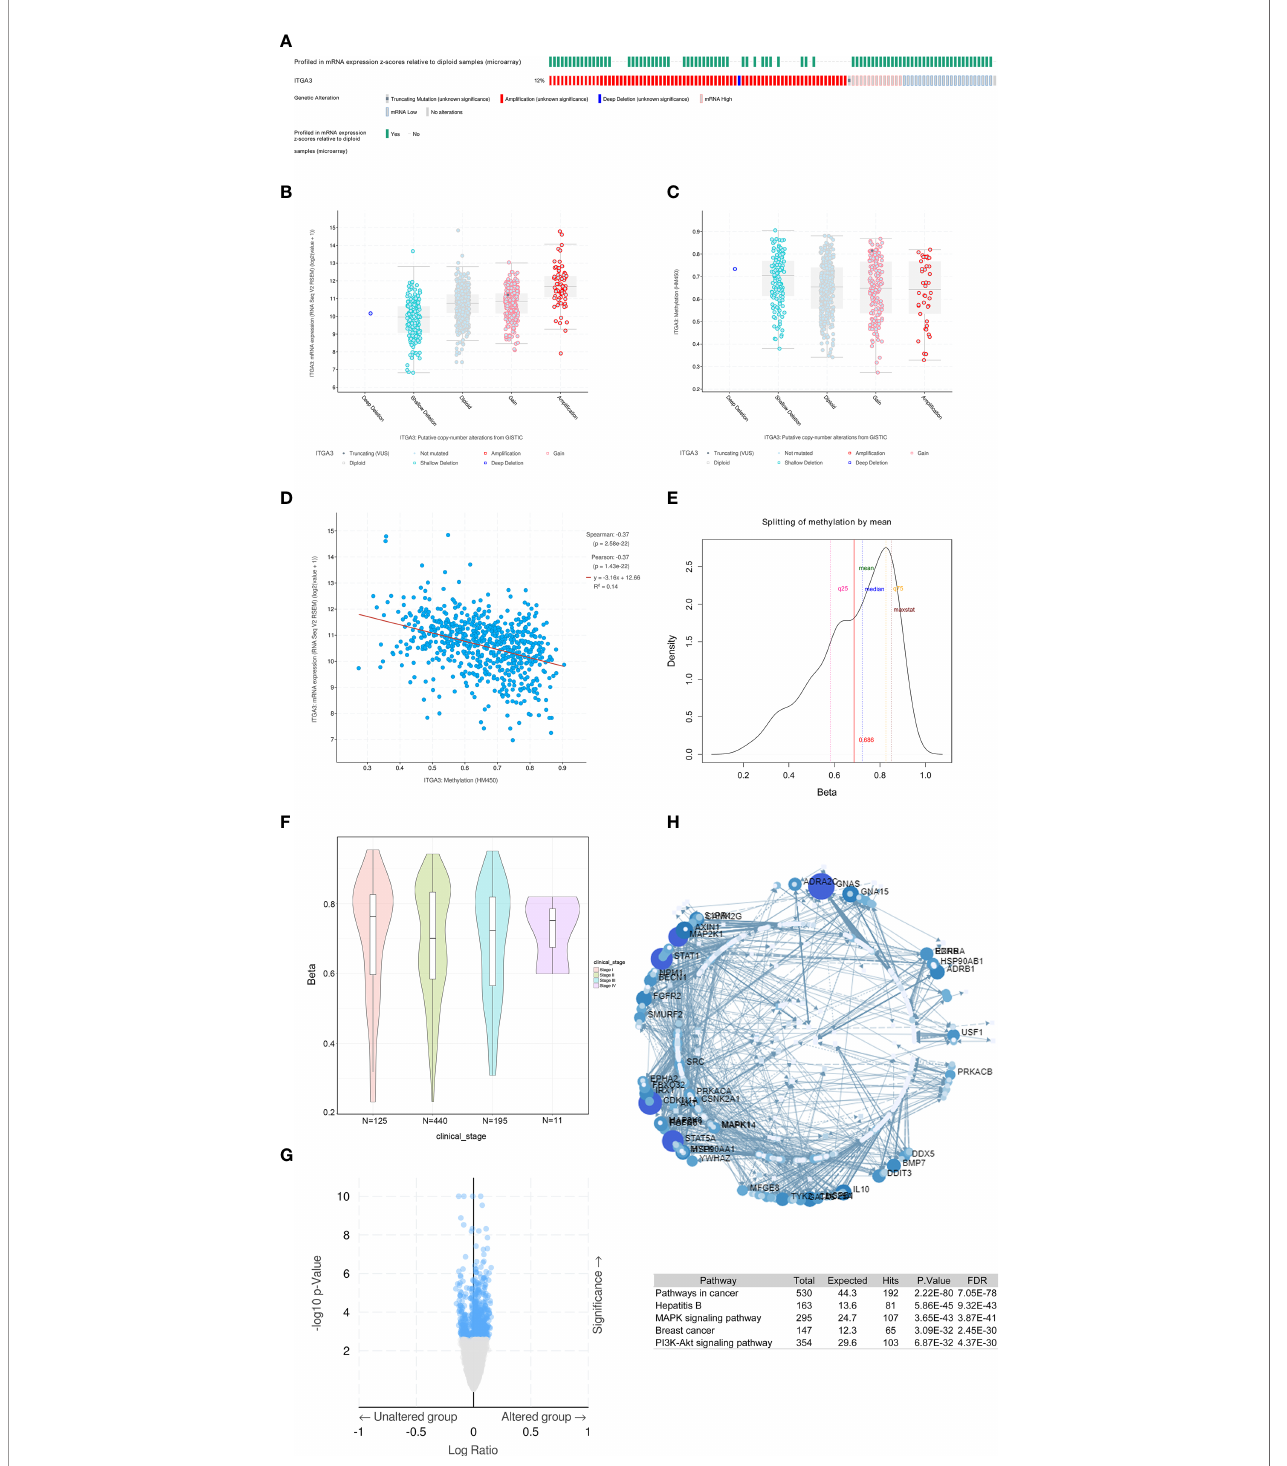
FIGURE 6 | ITGA3 genomic analysis in BRCA. (A) OncoPrint of ITGA3 alterations in BRCA cohort. The different types of genetic alterations are highlighted in different colors. (B) ITGA3 expression in different ITGA3 CNV groups. (C) ITGA3 methylation in different ITGA3 CNV groups. (D) The relationship between ITGA3 promoter methylation level and ITGA3 mRNA expression in BRCA. (E) TSS1500-N_Shore-cg11222053 probe methylation density map. (F) TSS1500-N_Shore- cg11222053 probe methylation pro fi les based on clinical stage. (G) Volcano plot of methylated genes between unaltered group and altered group. (H) Signaling network of methylated genes with signi fi cant